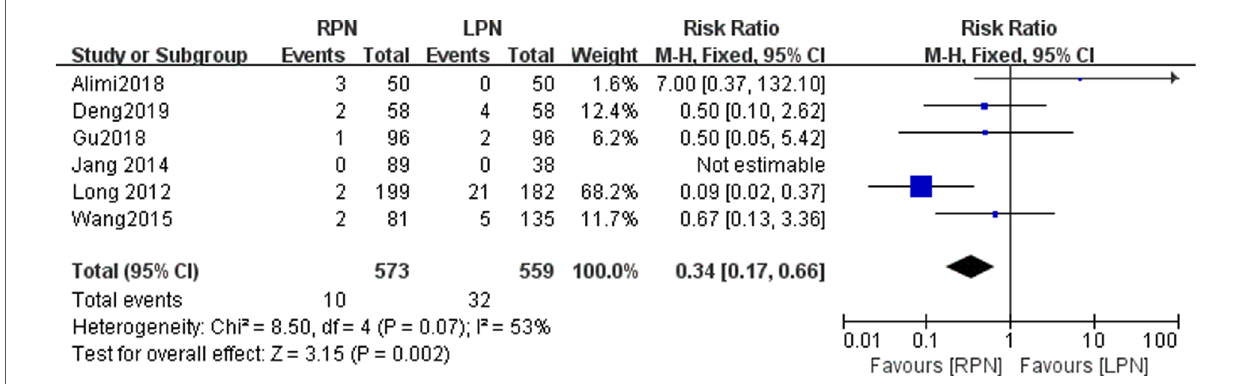
FIGURE 6 Forest plot for conversion between the RPN and LPN.